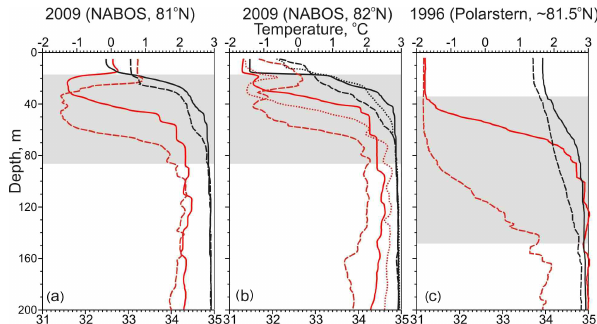
Figure 5. Vertical profiles of temperature (red, ◦ C) and salinity (black, psu) in the upper 200m layer taken in July 1996 and Septem- ber 2009 through the core of SFSBW inflow (solid line, a – station 23, b – station 85, c – 81 ◦ 27 0 N, 65 ◦ 51 0 E) and outflow (dashed line, a – station 25, b – station 77, c – 81 ◦ 17 0 N, 72 ◦ 01 0 E) to/from the ST. (b) The dotted line depicts the CTD profile taken in September 2009 through the core of the FSBW boundary current (station 80). For station positions in 2009 see Fig. 2. Gray shading highlights the outflow from the ST modified by vertical mixing.